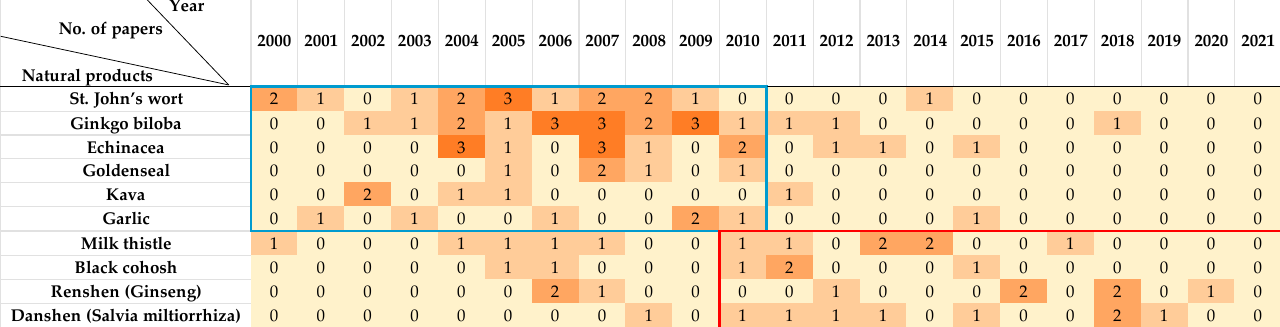
Figure 5. The number of research articles reporting the CYP450s’ modulation effects of the most popular natural products.